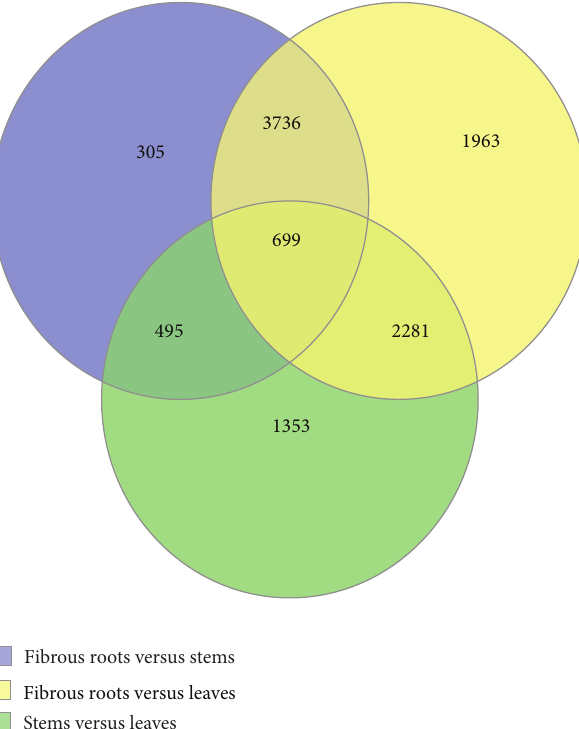
Figure 3: Venn diagram of differential expression of unigenes.